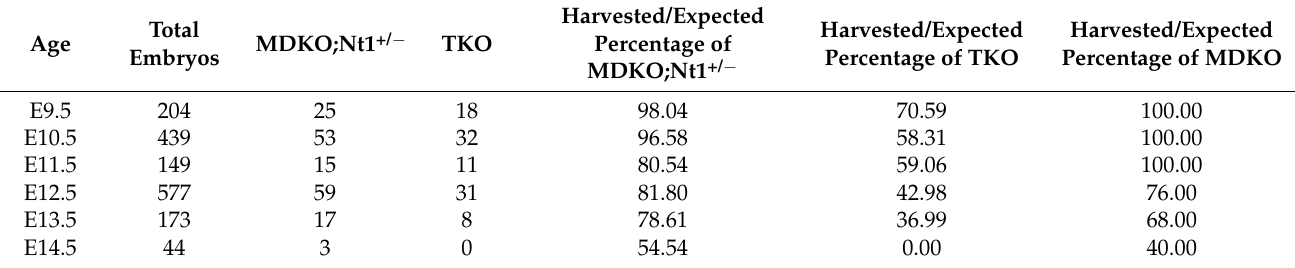
Table 2. Notch1 deletion in MDKO causes earlier death of the